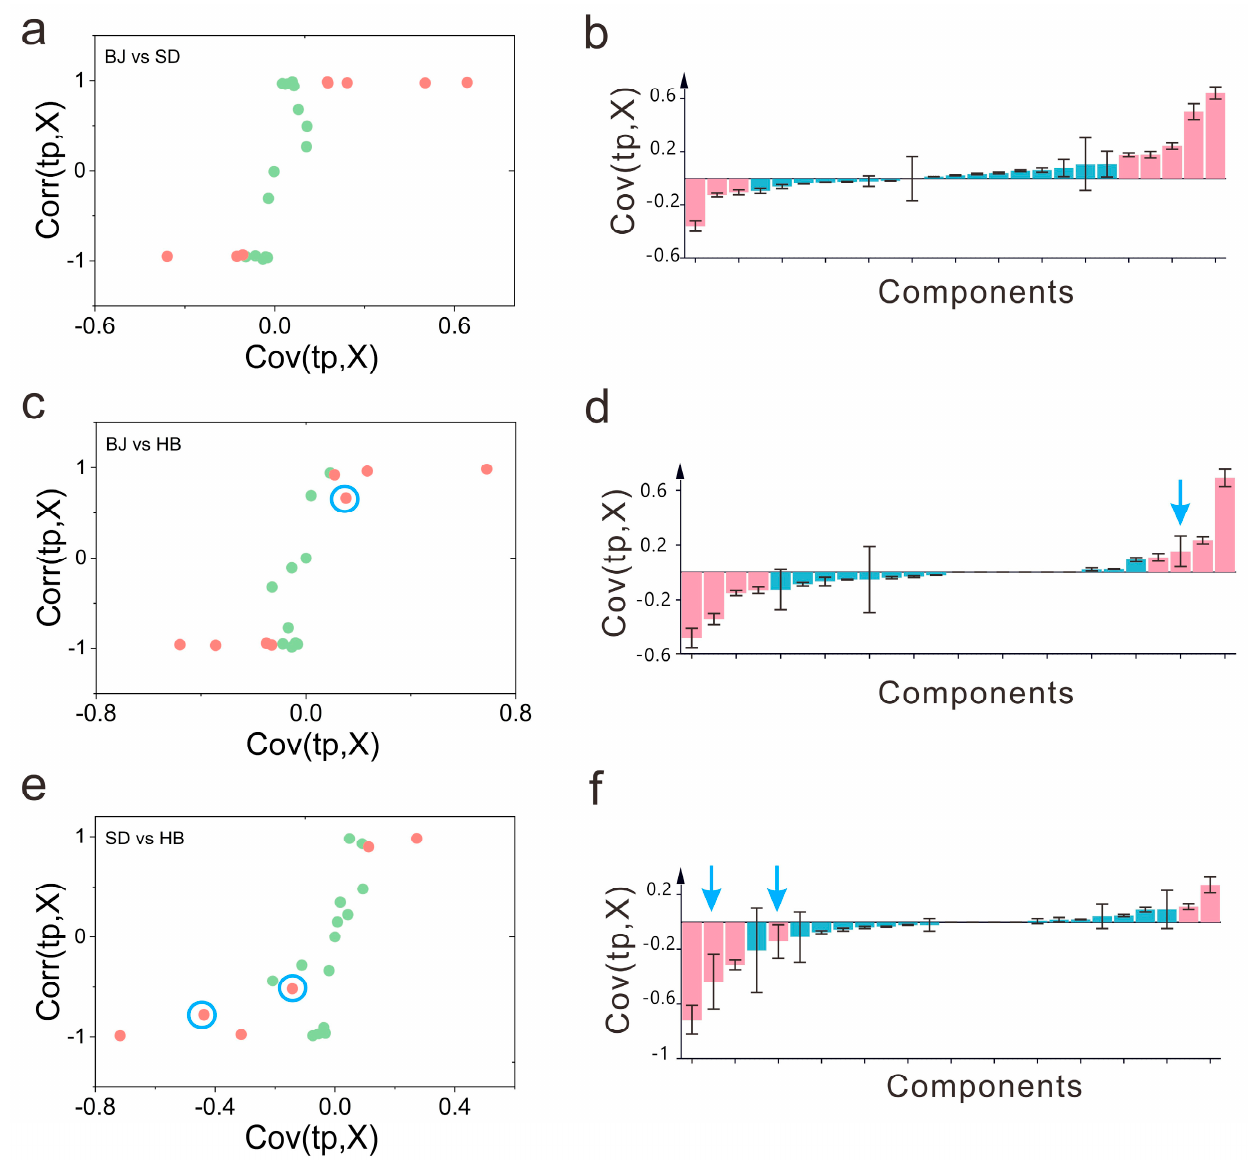
Figure 2. The S-plot and loading plot with jack-knifed confidence intervals. ( a ) S-plot of BJ vs. SD; ( b ) loading plot of BJ vs. SD; ( c ) S-plot of BJ vs. HB; ( d ) loading plot BJ vs. HB; ( e ) S-plot of SD vs. HB; ( f ) loading plot of SD vs. HB. The highlighted pink solid circle in S-plot represents the potential metabolites (|p(cov)| ≥ 0.1 and |p(corr)| ≥ 0.5); the highlighted pink rectangle with confidence interval represents the corresponding potential aroma in S-plot; the blue arrow in the loading plot represents the compound with high confident interval; the blue circle in the S-plot represents the corresponding compound in the loading plot. To sum up, the critical aroma components of the three groups of BJ vs. SD, BJ vs. HB, and SD vs. HB were ascertained with an S-plot together with the jack-knifed confidence intervals and VIP through the paired OPLS-DA approach in cooperation with the p values and FC. Overall, the five primary aroma compounds methyl acetate, (E)-hex-2-enal, ben- zaldehyde, [(Z)-hex-3-enyl] acetate, and 5-ethyloxolan-2-one were specified as differential biomarkers for the three